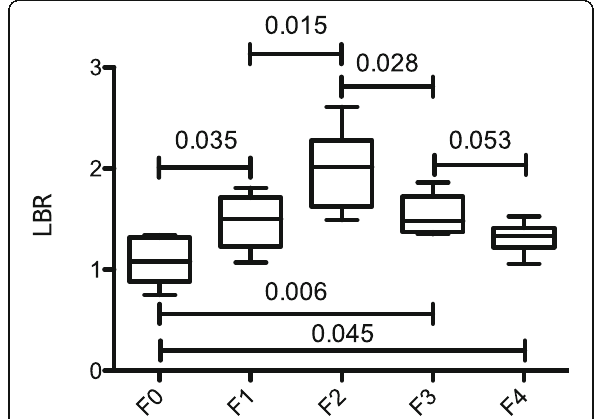
Fig. 3 LBR in patients with normal liver parenchyma and patients with liver fibrosis/cirrhosis. Mann-Whitney U tests were used to compare the groups: no (F0), mild (F1), advanced (F2), severe liver fibrosis (F3), and liver cirrhosis (F4)